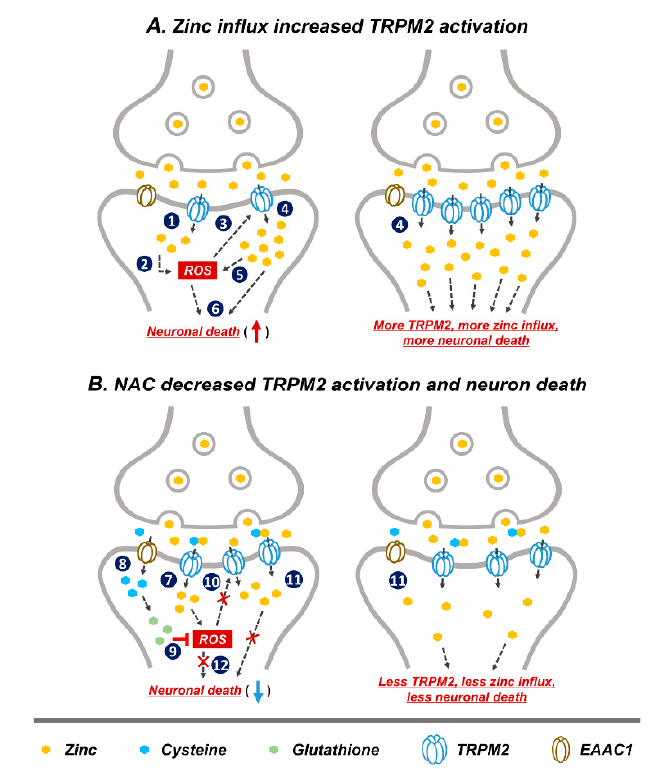
Figure 7. Predicted reactions of NAC post treatment on GCI ‐ induced neuronal death. Representative schematic illustration indicates NAC action via reduction of reactive oxygen species (ROS) production and subsequent decrease in TRPM2 activation. ( A ) (1) Released zinc after GCI moves into the post ‐ synaptic neurons through TRPM2. (2) Translocated zinc contributes to ROS production. (3) Oxidative damage including ROS activated TRPM2. (4) ROS ‐ induced TRPM2 activation increased secondary zinc influx. (5) Increased translocated of zinc contributes to greater ROS production. (6) Zinc and ROS induces neuronal death. (1)–(6) Image shows the hypothesized cascade produced upon GCI ‐ induced zinc influx and TRPM2 activation. ( B ) (7) Zinc translocated into the post ‐ synaptic neurons via TRPM2 after GCI. (8) Cysteine supplied by NAC administration moves into post ‐ synaptic neurons through